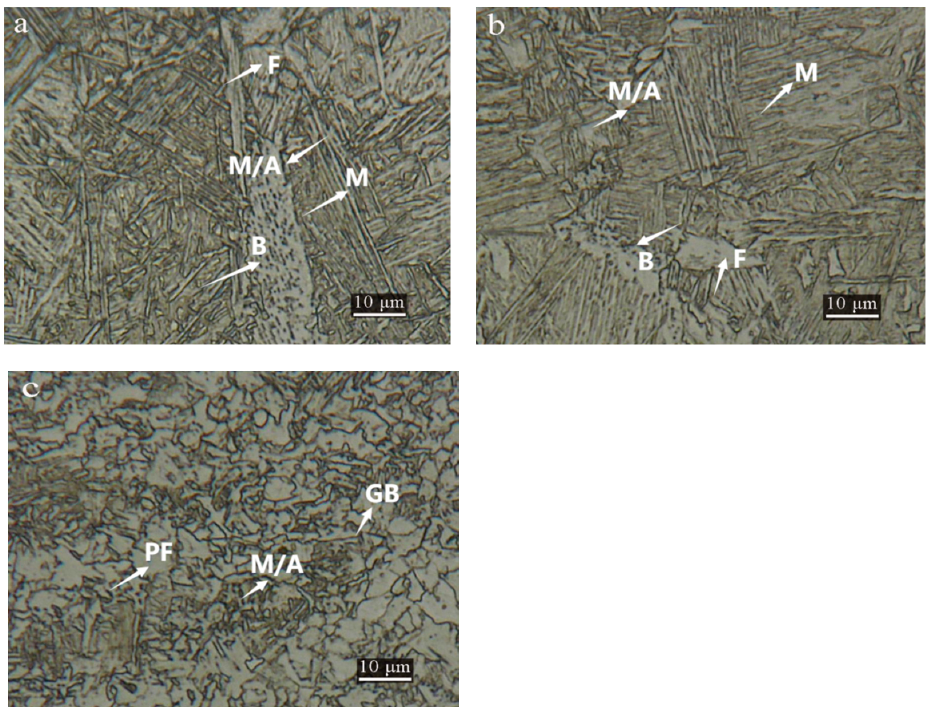
Figure 5. Microstructure of the X80 pipeline steel welded joint with the heat input of 4 kJ/cm: ( a ) welded metal; ( b ) CGHAZ and ( c ) FGHAZ.